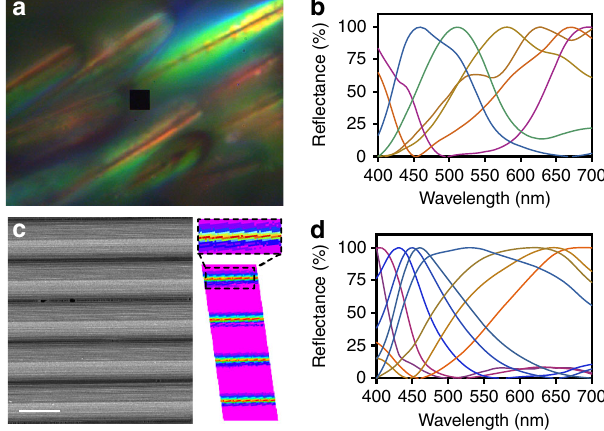
second con fi guration is a pentagonal prism that roughly resembles the shape of the scales with fl at surfaces and abrupt joints (prism, Fig. 4b); lastly the third con fi guration is a spider scale-mimic structure, with nanogratings on the two lenticular curved (i.e., with concentric convex curvature) sides (foil, Fig. 4c). For the pentagonal prism con fi guration, the nanogratings are on the four upward-facing surfaces except for the base and the sides (Fig. 4b). This design is partly inspired by the iridescence-